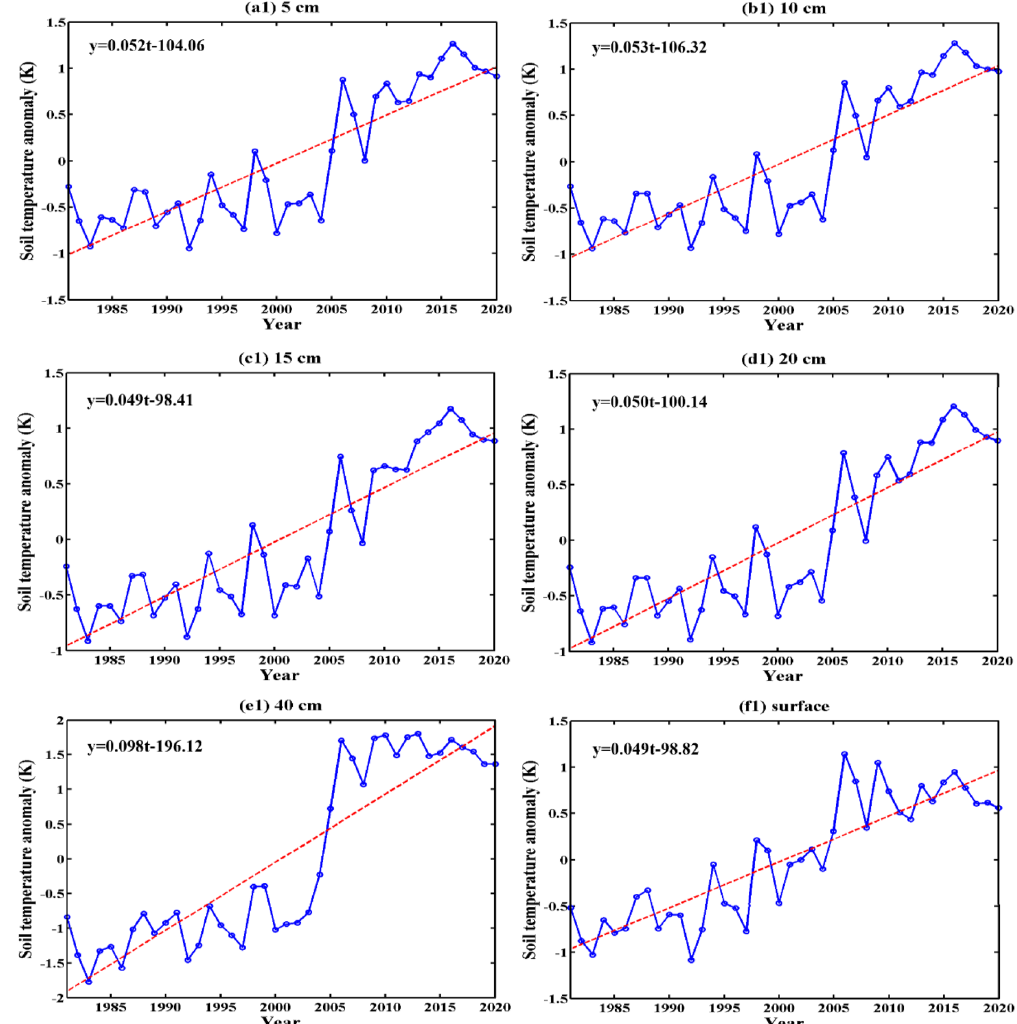
Figure 4. Interannual variation in shallow ST anomalies on the Qinghai-Tibet Plateau (unit: K, α = 0.01 F c the distribution coefficient ( δ F , F c 1 ). When the change in the distribution coefficient is the smallest and − + the change in entropy is the largest, C is determined. Using FCM, based on 20 cm ST at 141 sites on the Qinghai- Tibet Plateau, 7 regions were clustered. The classification results are shown in Fig. 8, and the environmental parameters of the cluster centers are shown in Table 2. The Qinghai-Tibet Plateau was divided into 7 regions according to the characteristics of the 20 cm ST, namely, the northeastern Tibetan Plateau, southern Tibet, the Xining Plateau, the Qiangtang Plateau, the western Sichuan Plateau, the eastern Tibetan Plateau and the vast Central Plateau. Lin et al. 70 pointed out that the northeastern Loess Plateau is a sub-Arctic semihumid climate zone, with an average altitude of approximately 4000–4600 m, fewer than 50 days with a temperature ≥ 10 °C, and an average temperature of 8–10 °C in the warmest month. In Table 2, the average temperature of the 20 cm soil was the lowest, which was 5.2 °C; southern Tibet is a temperate and semiarid climate zone, and a large area is a wide river valley. The middle and upper reaches of the Yarlung Zangbo River are located in this region, with an average altitude of 3500–4500 m. The number of days when the temperature is ≥ 10 °C ranges from 50 to 150 days. The average temperature of the warmest month is 10–15 °C, while the average temperature of the 20 cm soil is relatively slightly higher, at 10.9 °C; the Xining Plateau is a temperate and semiarid climate zone, located in the eastern part of Qinghai Province, with complex terrain. The altitude of the valley area is below 2200 m, the average altitude is 2700–3300 m, the number of days with tem- perature ≥ 10 °C ranges from 50 to 150 days, and the average temperature of the warmest month is 11–13 °C. The average ST of 20 cm is 8.9 °C. The Qiangtang Plateau is a frigid semiarid climate zone with gentle terrain fluctua- tions; the average altitude is 4300–5100 m, there are fewer than 50 days with a temperature ≥ 10 °C, and it has an average temperature of 8–10 °C in the warmest month. The average ST of 20 cm is 7.6 °C; the western Sichuan Plateau is a temperate humid climate zone located on the eastern edge of the Qinghai-Tibet Plateau. The terrain fluctuates greatly, and the average altitude is 1500–3400 m. The number of days when the temperature is ≥ 10 °C ranges from 120 to 180 days. The average ST of 20 cm was the highest, which reached 17.1 °C. The eastern Tibetan Plateau is a temperate semihumid climate zone, with an altitude of approximately 2700–4000 m; additionally,